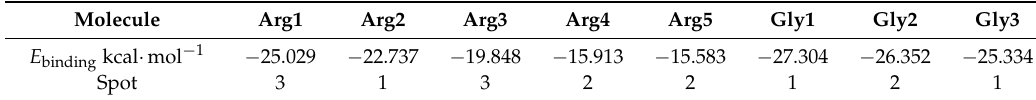
Figure 5. Molecular docking results for arginine and glycine obtained with GLUE software. A33 is displayed in blue ribbons, arginine in green and glycine in red ( left ); The higher affinity molecules are displayed as larger CPK. A33 residues involved in each identified spot ( right ). Table 1. Binding affinity and hotspot for each arginine and glycine solutions.